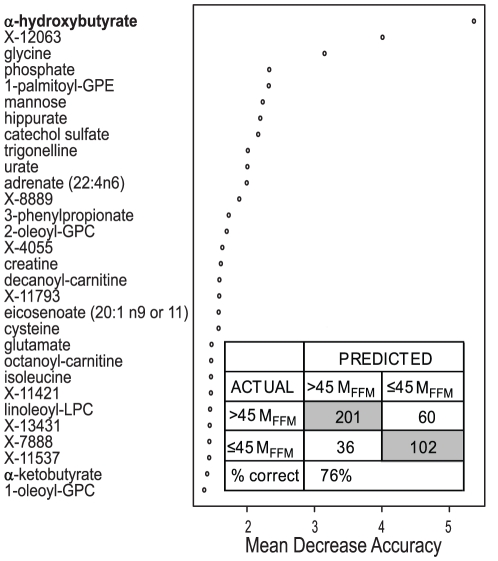
Classification of subjects as insulin sensitive or insulin resistant.Random Forest statistical analysis of biochemical profiling (metabolomic) data. The Importance Plot rank of metabolites according to the contribution of each to the classification of 399 subjects into insulin sensitive (IS, MFFM>45 µmol·min−1·kgFFM
−1, top two-thirds of subjects, n = 261) or insulin resistant (IR, MFFM<45 µmol·min−1·kgFFM
−1, bottom third of subjects, n = 138) groups. Metabolites are listed on the y-axis in order of importance, decreasing in importance from the top to bottom. The mean decrease in accuracy for each metabolite is plotted on x-axis. INSET: The Confusion Matrix showing the prediction accuracy of the separation of the top two-thirds (IS) from the bottom third (IR) is ∼76%.